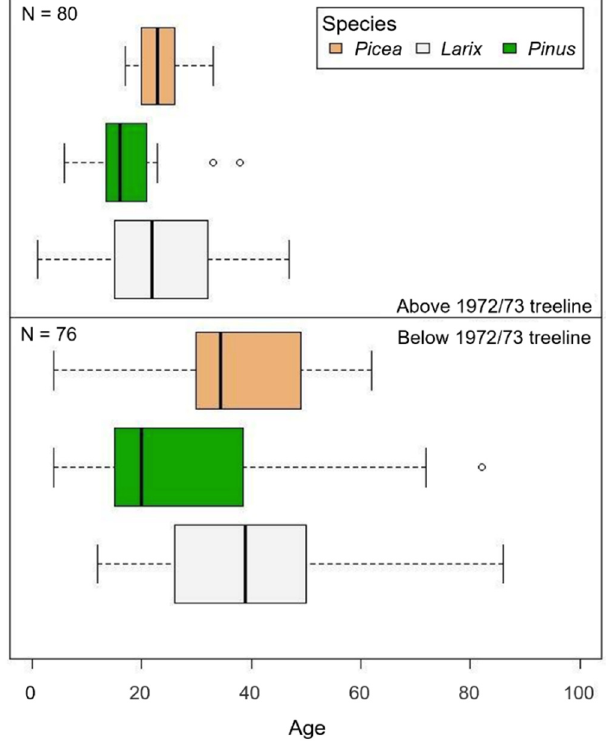
Figure 4. Tree age above ( upper panel ) and below ( lower panel ) the 1972 treeline based on dendrochronological analysis of a subsample of trees on both south- and north-facing valley slopes. Number of sampled trees above treeline: Picea (N = 9), Larix (N = 56), Pinus (N = 15) and below treeline: Picea (N = 29), Larix (N = 16), Pinus (N = 31).